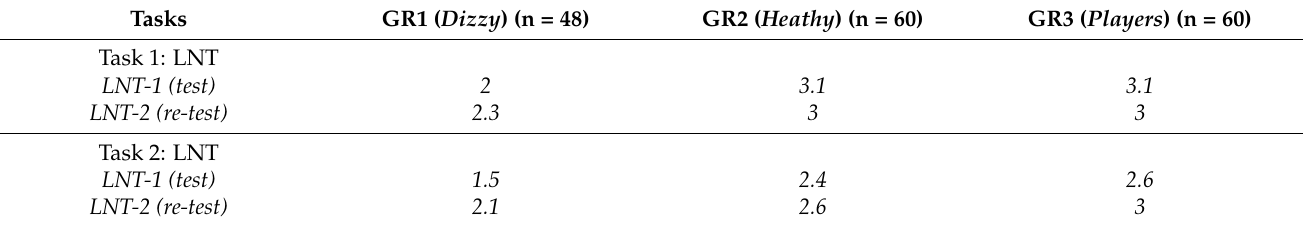
Figure 2. Navigation Ability Test (NAT 2.0). Task 2 (Red): the subject will actively walk with open eyes along a second path, marked by red numbered cones, in the two directions of travel, for 2 consecutive times that must be then repeated with closed eyes. In the absence of visual control, the subject, instant by instant, must draw only on the previously acquired labyrinthine information, expression of the SWM. Table 1. NAT 2.0 scores (0 to 4) for tests and re-tests in dizzy patients (GR1), healthy non-sporting patients (GR2), and football players (GR3); LNT: Labyrinth Navigation Task.